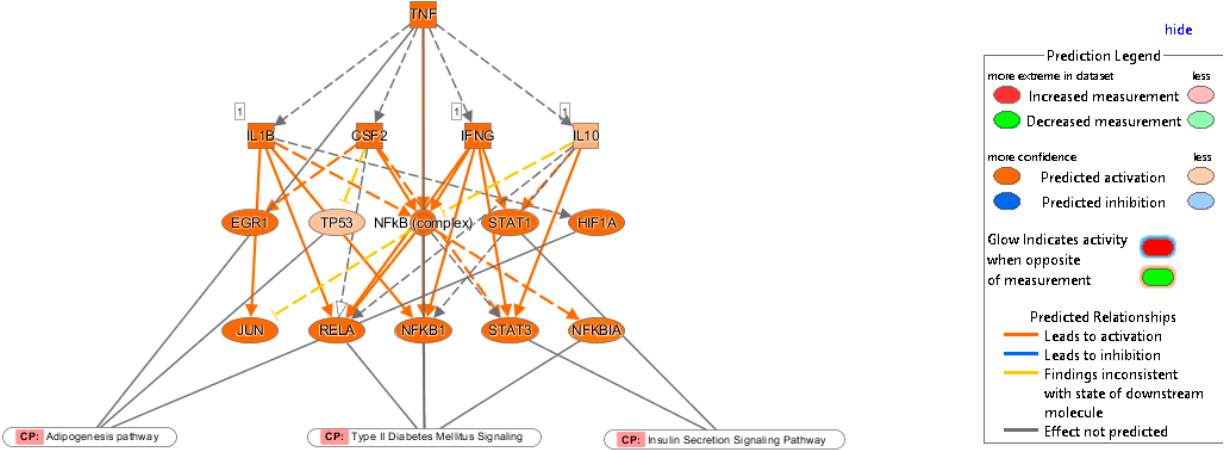
Figure 7. Network of TNF in obese subjects with T2D, its targeted genes and corresponding T2D. For example, activation of TNF leads to upregulation (indicated by orange line) of DEG (shown by orange color). Upregulation of DEGs further affects insulin secretion signaling pathway (CP). For other indicators, please refer to the prediction legend.